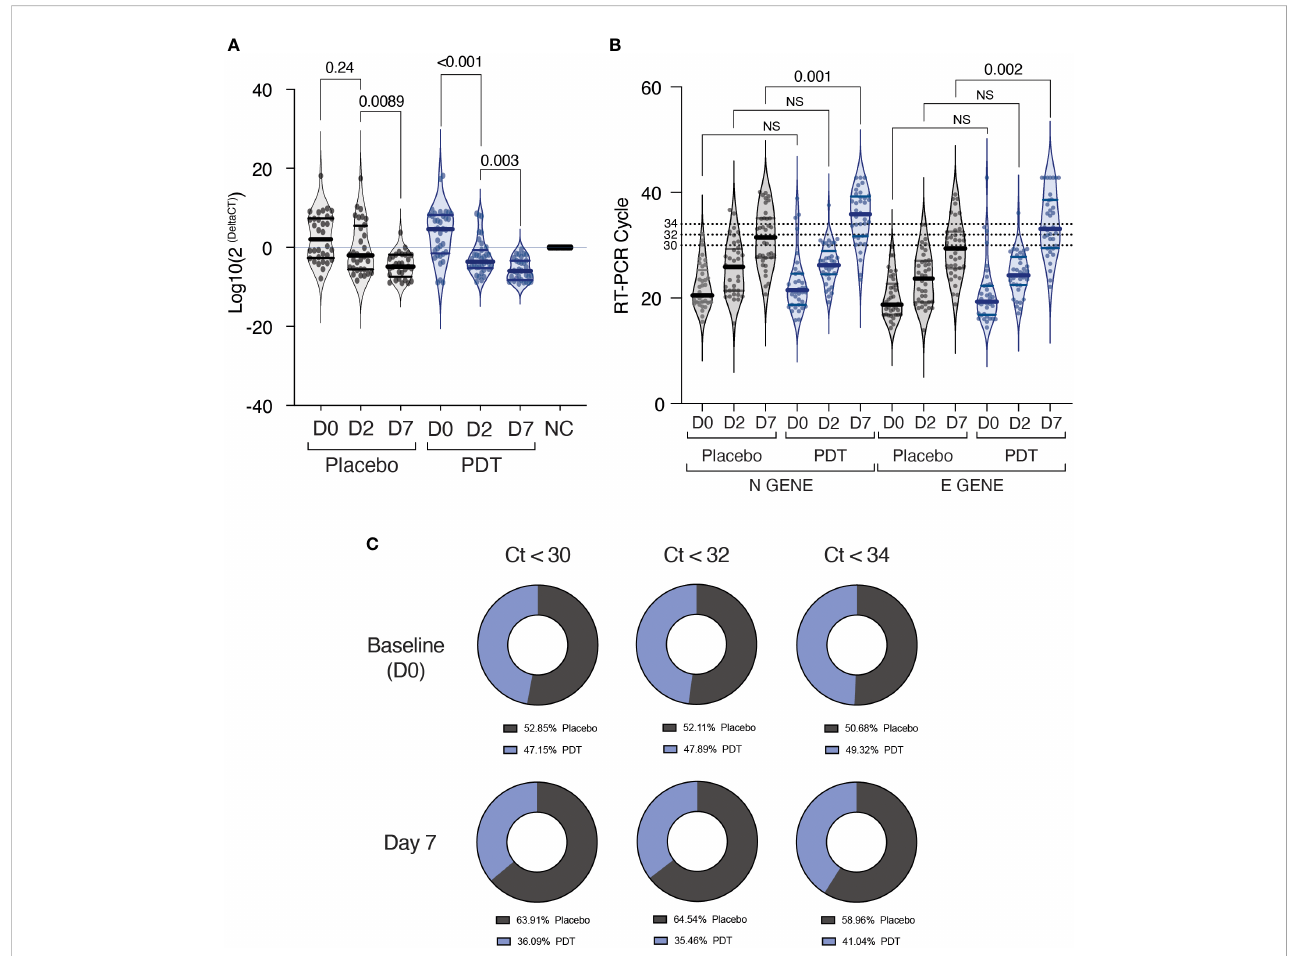
FIGURE 2 Results of infectivity assays and RT-PCR on Nasopharyngeal Swabs. (A) Infectivity assays. Subjects recruited in the study underwent nasopharyngeal swabs at baseline (Day 0), at day 2 and at day 7. The sample was collected in Viral transport medium and was subsequently used for the analysis of infectivity on VeroE6 cells. Seventy-two hours after infection, the supernatant was tested for the presence and quantity of SARS-CoV-2 using RT-PCR for Orf1b gene and human beta actin. Data is expressed in log10 of the delta between beta actin and Orf1b gene fl uorescence threshold cycle. A Wilcoxon test for paired data was used for comparing baseline to D2 and D2 to D7. (B) RT-PCR of E and N genes of SARS-CoV-2 from nasopharyngeal swab samples immediately after collection. Data is expressed in fl uorescence threshold cycle. A Wilcoxon test for paired data was used for comparing baseline to D2 and D2 to D7. (C) Percentage of “ positive ” and “ negative ” individuals in each of the two groups at baseline, D2 and D7, depending on which cycle threshold was chosen. NS, Non Signi fi cant; NC, Negative Control; PDT, Photodynamic